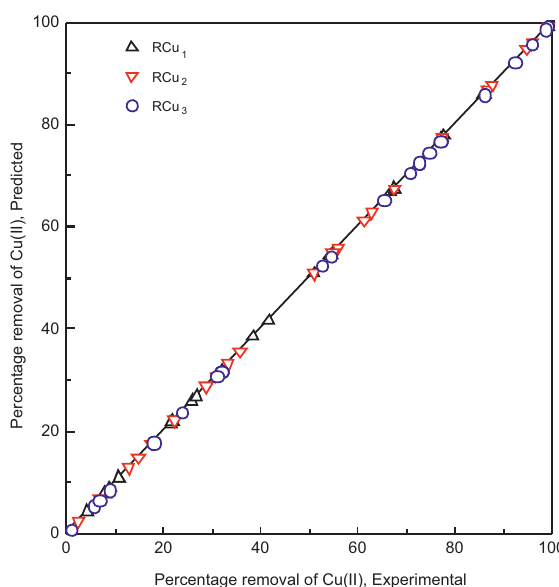
Figure 10. Final comparison related to GA prediction